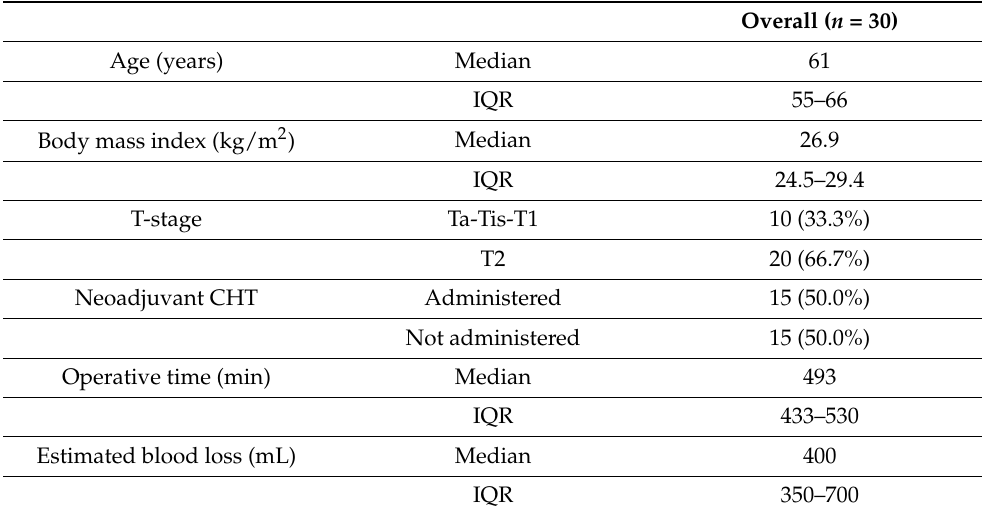
Table 1. Preoperative and intraoperative outcomes of 30 patients with non-metastatic bladder cancer treated with robot-assisted radical cystectomy and Shell-shape ileal ortothopic neobladder reconstruction.